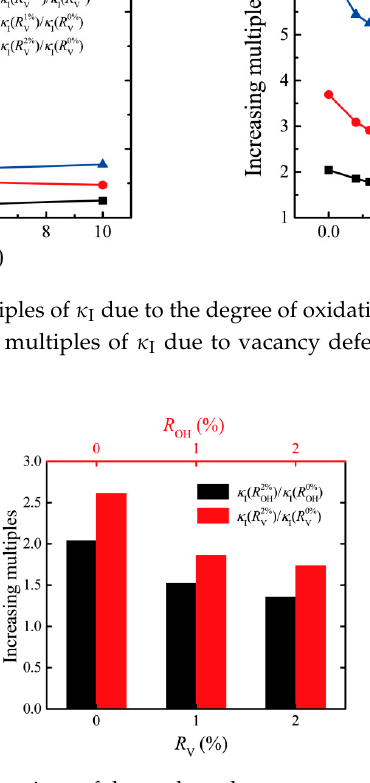
Figure 6. Change degree comparison of thermal conductance caused by defects and oxidation.